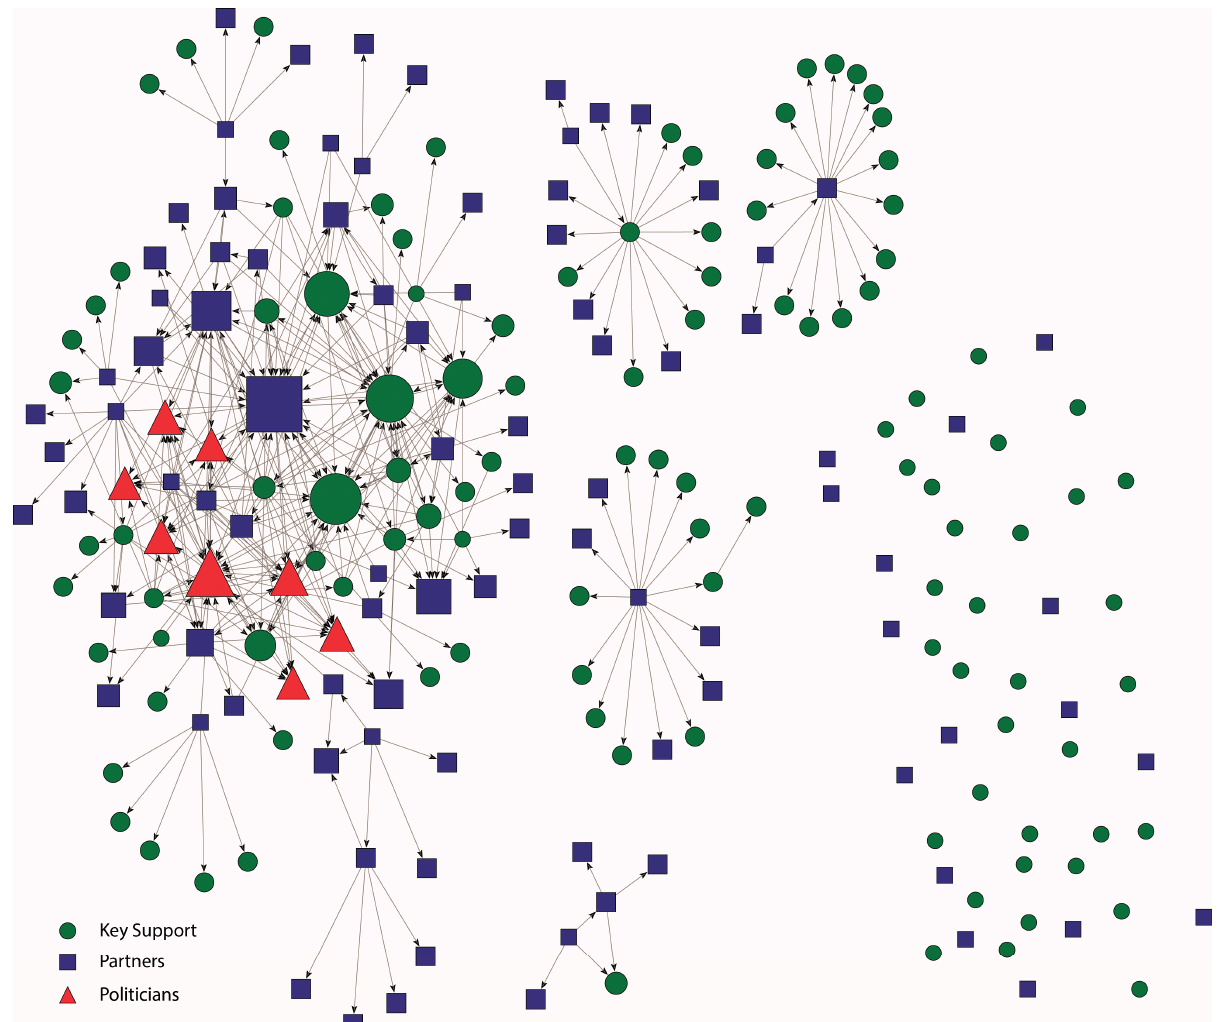
Figure 3. St. Louis Smokefree Policy Importance network. Nodes are sized according to the number of importance nominations. Links show direction of importance